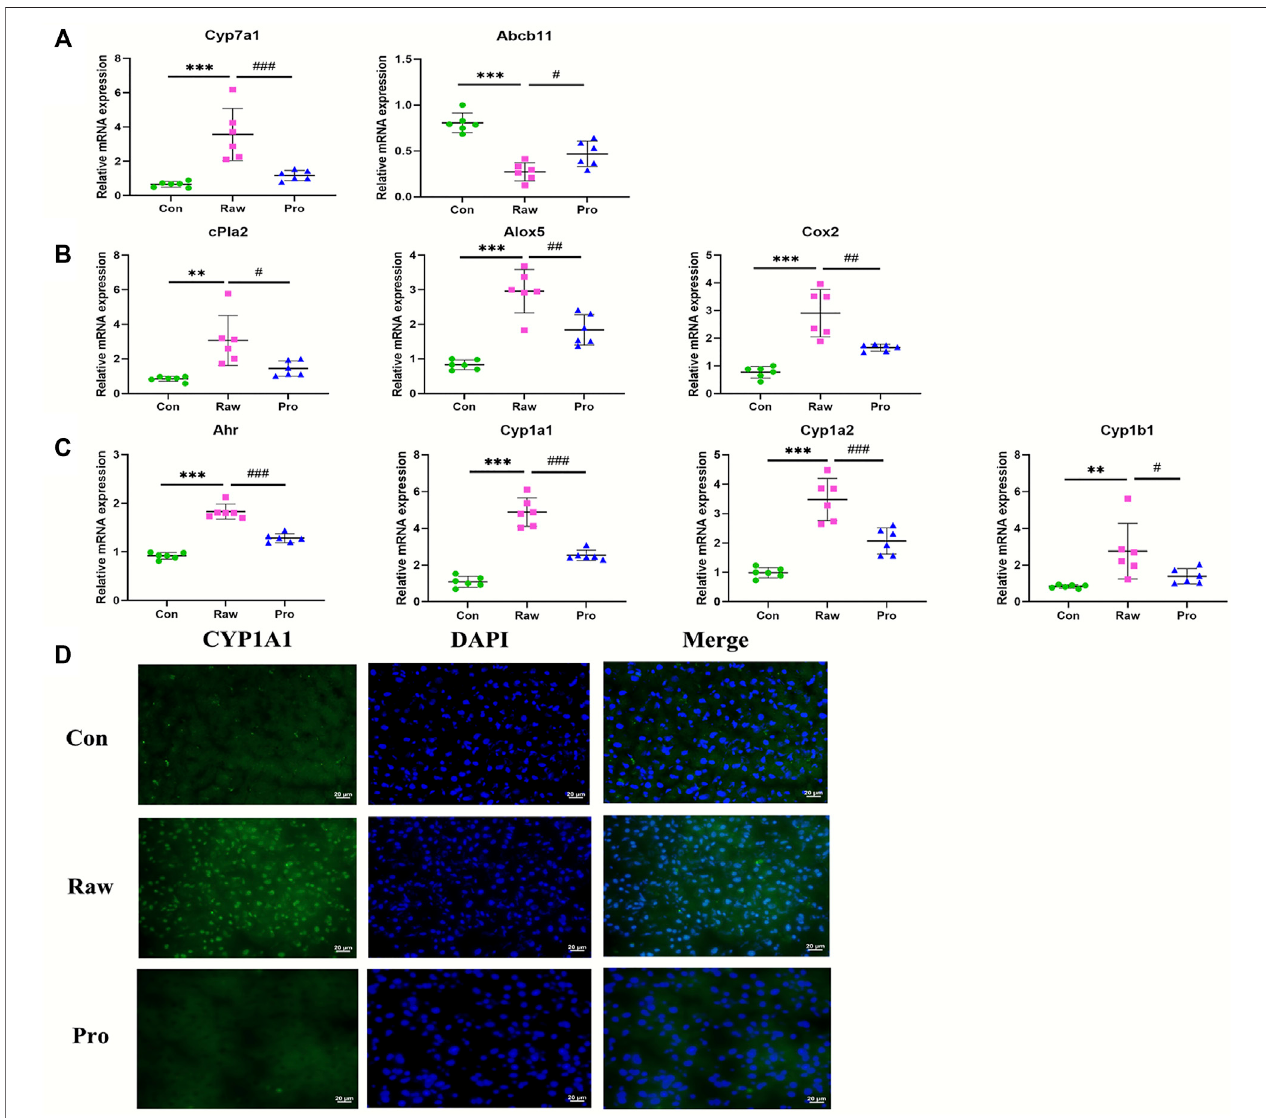
FIGURE 4 | RT-qPCR analysis of liver mRNA expression in rats treated with 70% ethanol extract of TR. (A) Primary bile acid biosynthesis rate-limiting enzyme Cyp7a1 and biliary salt excretion pump gene Abcb11 ; (B) arachidonic acid metabolic pathway activation-related genes: cPla2 , Alox5 , and Cox2 ; (C) Ahr and Ahr target genes: Cyp1a1 , Cyp1a2 , and Cyp1b1. Data are expressed as means ± standard error of the mean (n = 6). * p < 0.05, ** p < 0.01, and *** p < 0.001 for the comparison of the raw TR and control groups. # p < 0.05, ## p < 0.01, and ### p < 0.001 for the comparison between the processed TR and raw TR groups. (D) Nuclear translocation of the Ahr target gene, Cyp1a1